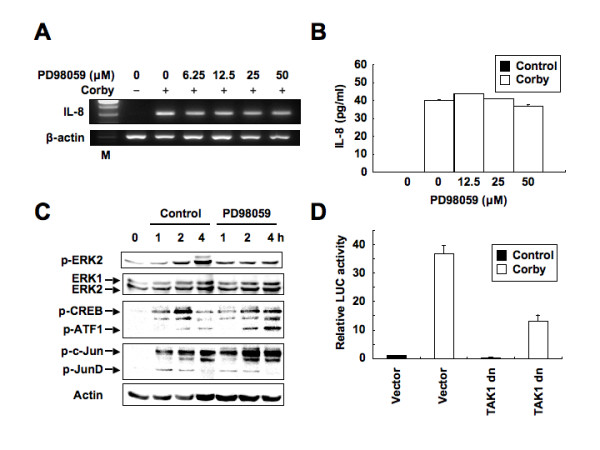
TAK1 but not ERK plays key roles in L. pneumophila-induced IL-8 expression. (A) Jurkat cells were pretreated with the indicated concentrations of PD98059 for 1 h prior to L. pneumophila Corby infection and subsequently infected with Corby (MOI, 100:1) for 4 h (A) and 24 h (B). IL-8 mRNA expression on harvested cells was analyzed by RT-PCR (A) and the supernatants were subjected to ELISA to determine IL-8 secretion (B). Data are mean ± SD of three experiments. (C) Jurkat cells were pretreated with or without PD98059 (50 μM) for 1 h prior to L. pneumophila Corby infection and subsequently infected with Corby (MOI, 100:1) for the indicated times. Cell lysates were prepared and subjected to immunoblotting with the indicated antibodies. (D) Jurkat cells were transfected with -133-luc and a dominant negative mutant of TAK1 or empty vector and then infected with Corby for 6 h. The solid bar indicates LUC activity of -133-luc without Corby infection. The activities are expressed relative to that of cells transfected with -133-luc and empty vector without further Corby infection, which was defined as 1. Data are mean ± SD of three experiments. Data in (A) and (C) are representative examples of three independent experiments with similar results.